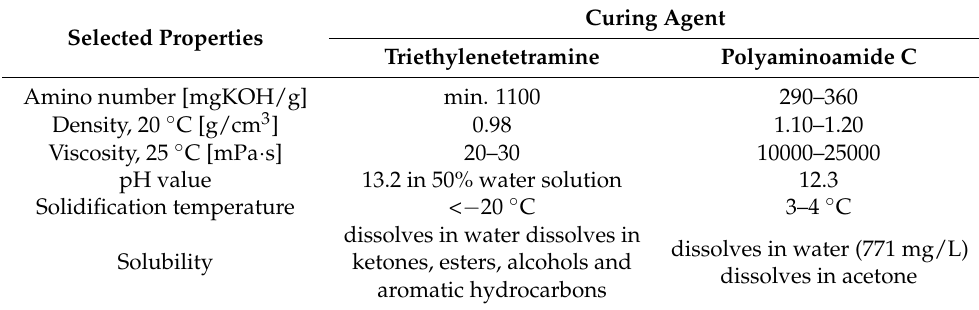
Table 2. Selected properties of curing agents.